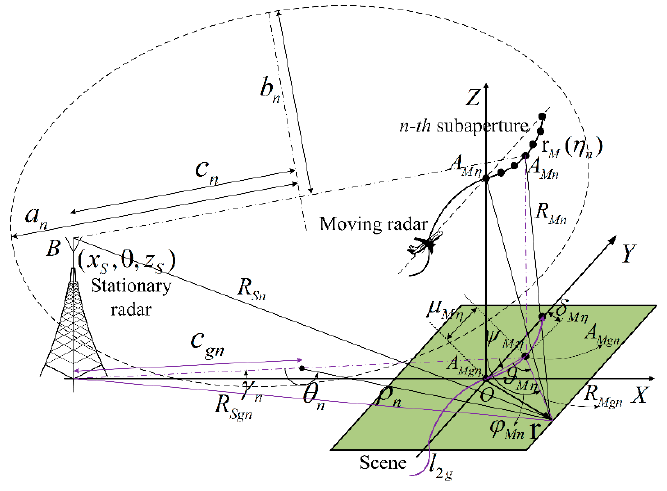
Figure 3. Bistatic range calculation in the proposed ETDA.